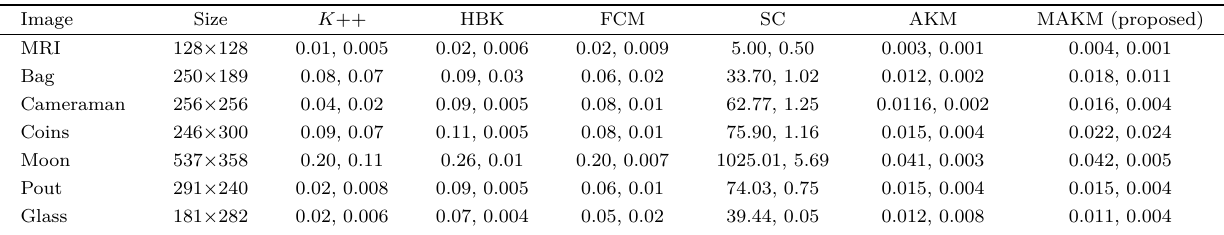
Table 4 Comparison of algorithms in terms of mean computation time and standard deviation (time (s), σ )